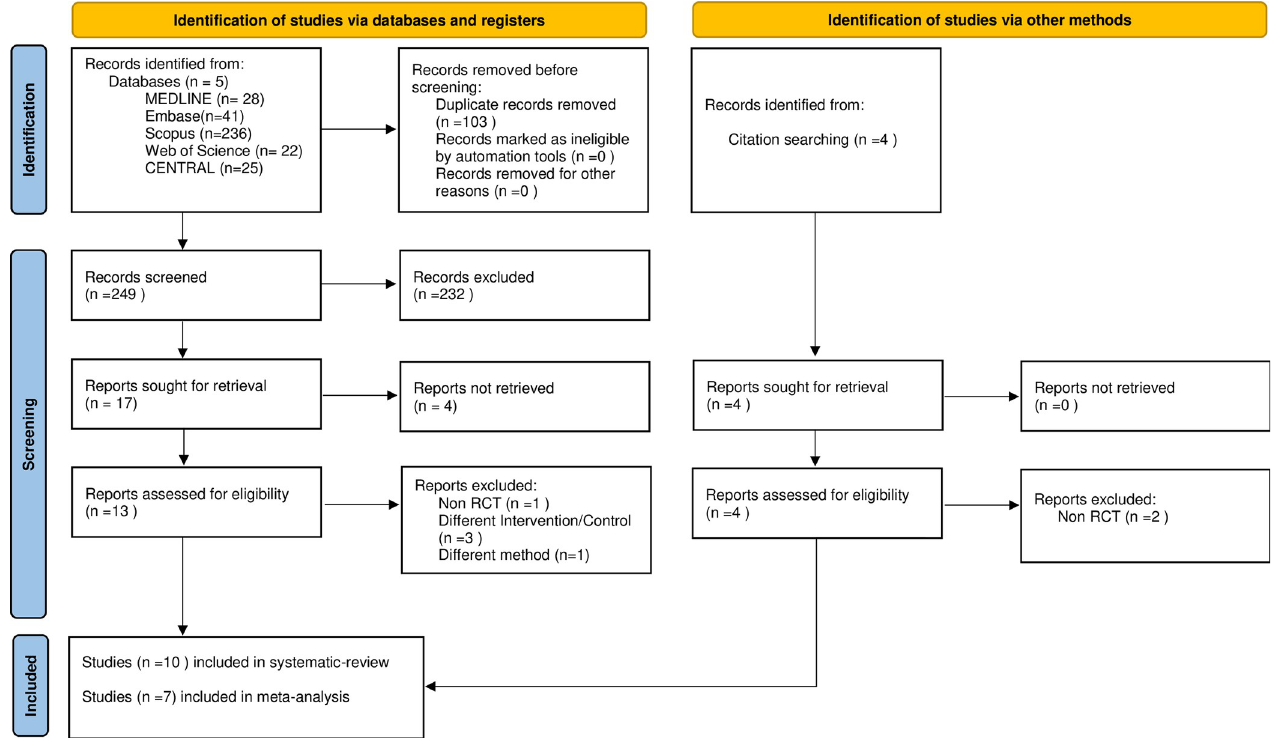
Fig 1. Prisma 2020 flow diagram of the screening and selection process.